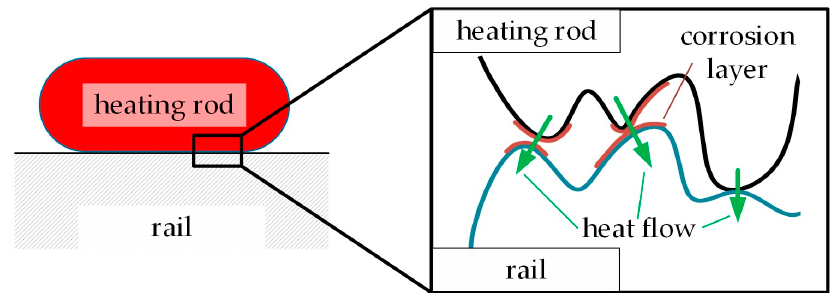
Figure 3. Heat flow through metallic contacts, corrosion layers, and the air gaps at the interface of the heating rod and rail.